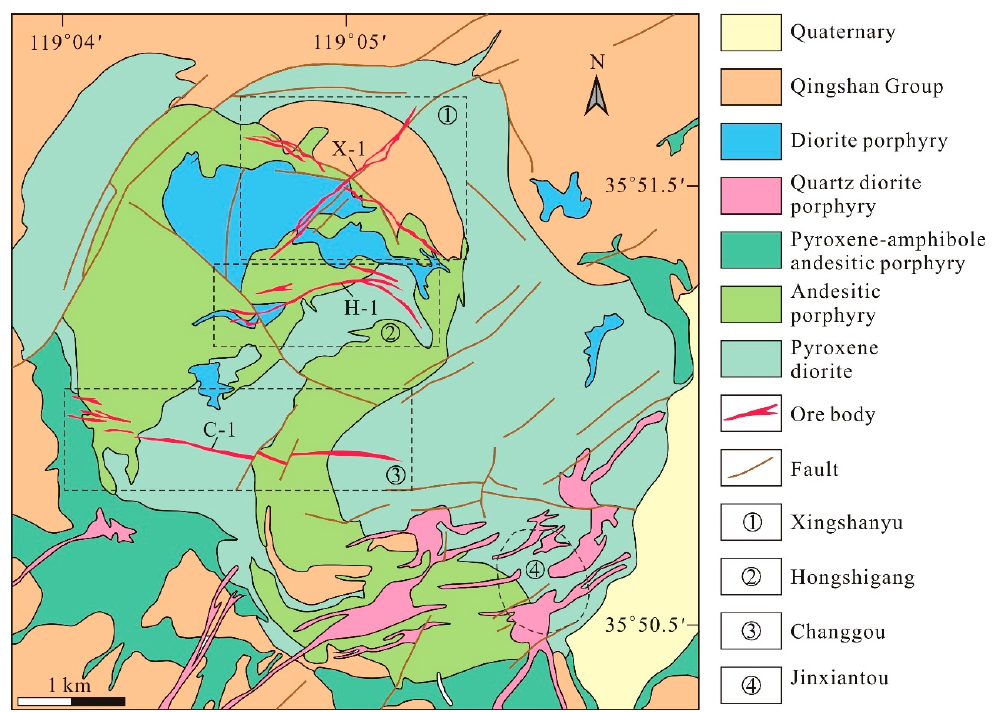
Figure 2. Geologic map of the Qibaoshan polymetallic ore field (Reproduced with permission from Zhang [22]).